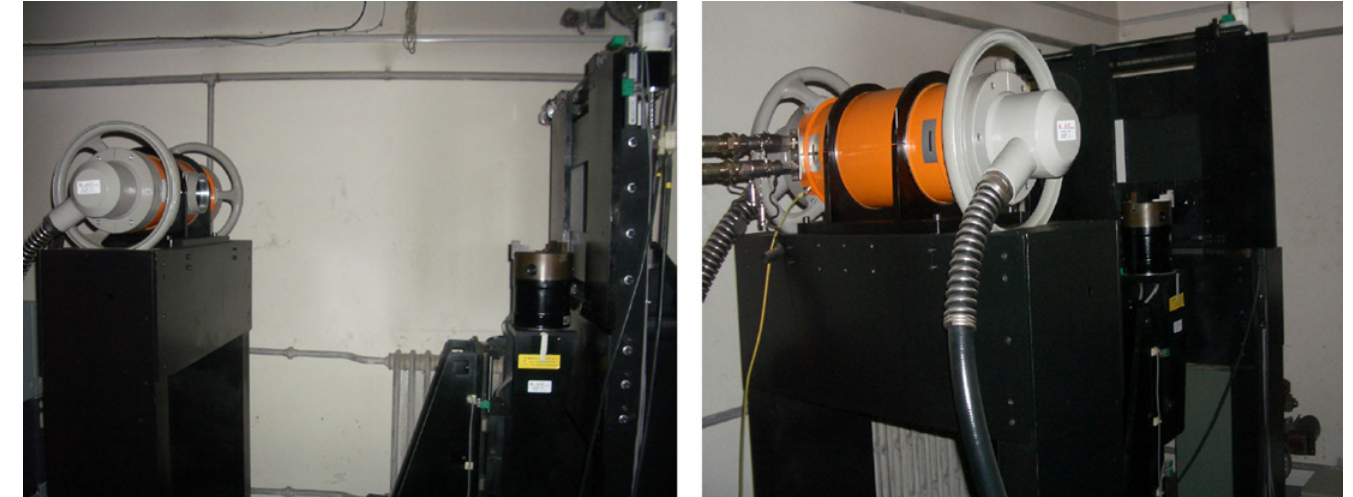
Fig 4. The experiment CT system. This system is composed by X-ray (GE ISOVOLT 450KV) and detector (VARIAN